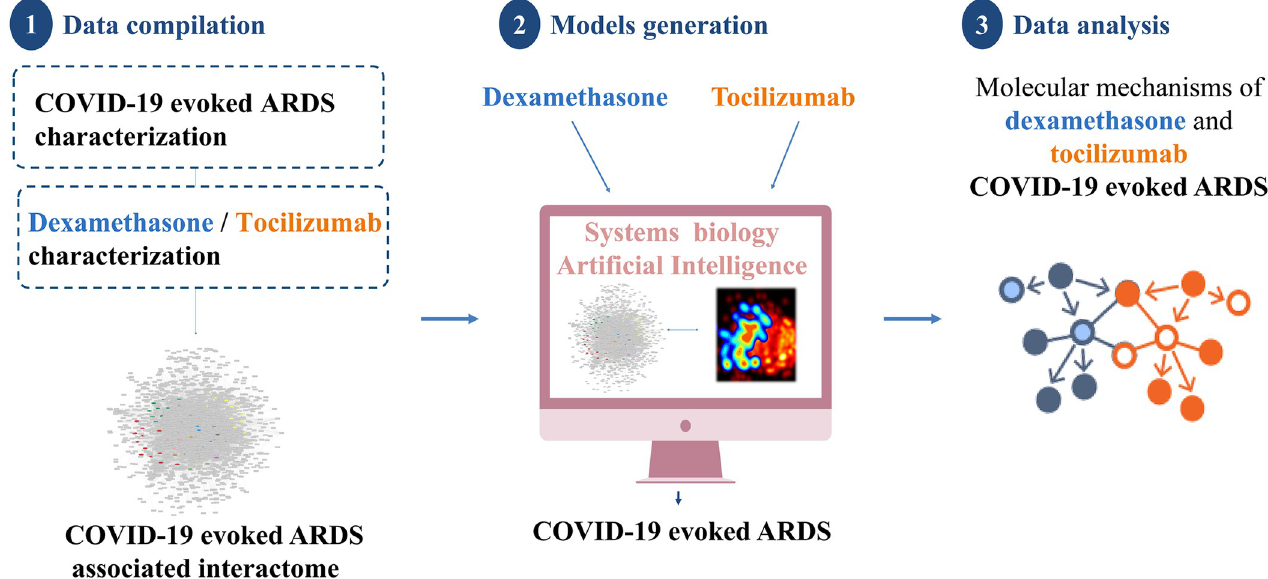
Fig 1. Study workflow. Overview of the in silico approach showing the main phases employed to simulate the MoA of dexamethasone and tocilizumab with respect to COVID-19 evoked ARDS, including: 1) data compilation for molecular characterization of COVID-19 evoked ARDS, dexamethasone and tocilizumab obtained from literature review; 2) mathematical model generation using the validated top-down systems biology- and AI-based TPMS approach; and 3) data analyses employing model outputs. AI, artificial intelligence; ARDS, Acute respiratory distress syndrome; MoA, mechanism of action; TPMS, Therapeutic Performing Mapping